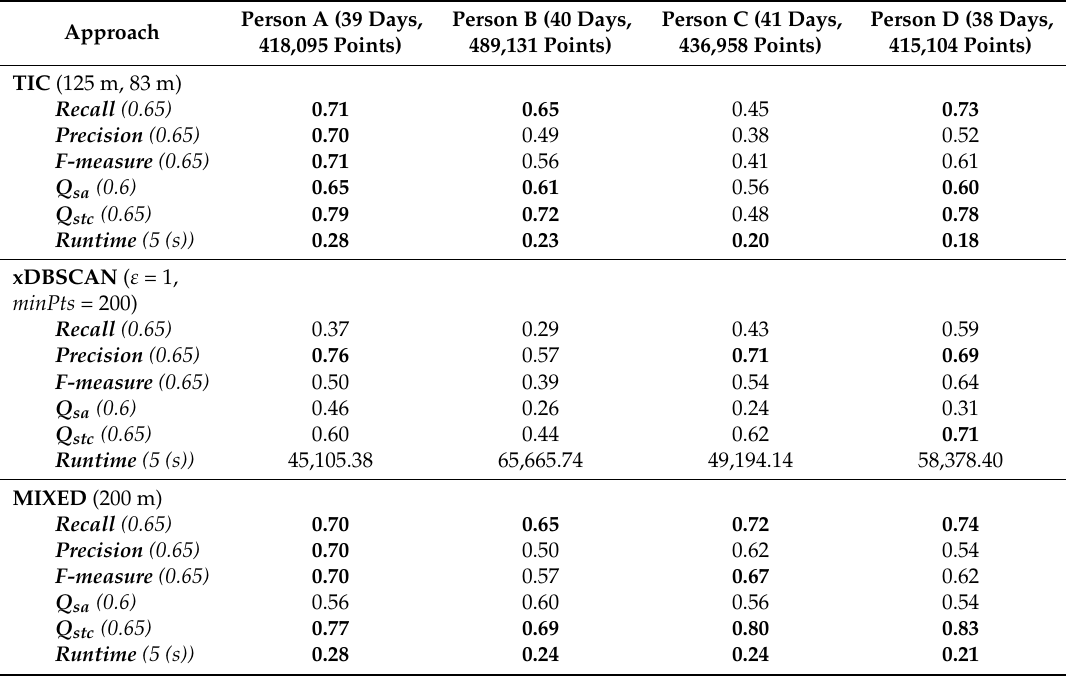
Table 3. Ground truth data (GTD) evaluation results for Time-Based/Incremental Clustering (TIC), xDBSCAN, and MIXED (bold values indicate that thresholds are met).